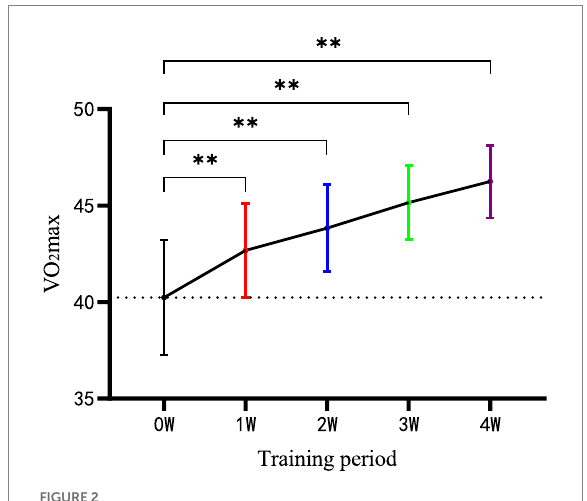
FIGURE 2 Weekly measurement of maximum oxygen uptake (VO2max) in the HIIT group during the four-week training. W, week; ** p <